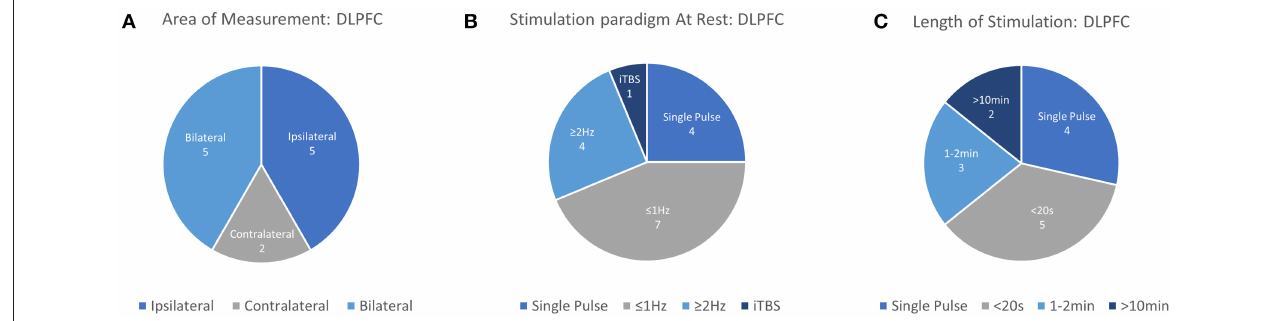
FIGURE 4 | Details of TMS-fNIRS studies applied at rest to the DLPFC for (A) Hemisphere measured, (B) Stimulation paradigm, and (C) Length of